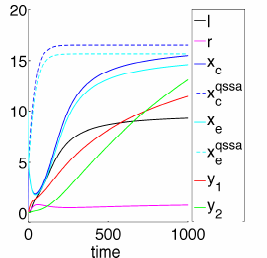
Fig. 12: Simulation of the basic model (Eq.(1)- (6)) with parameters from Table IV, α l = 0 . 001 and initial conditions x e = 10 and x c = r = y = y = l = 0 . The variables x qssa c and x qssa e 1 2 correspond to the basic system with quasi-steady state assumption. R